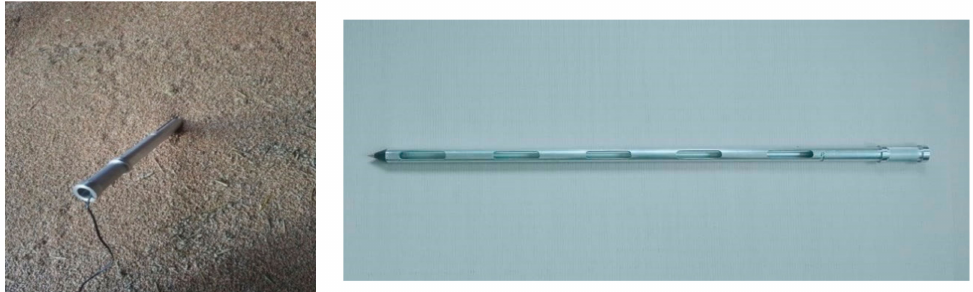
Figure 1. The multichamber probe for sampling. [Source: K. Szwedziak].